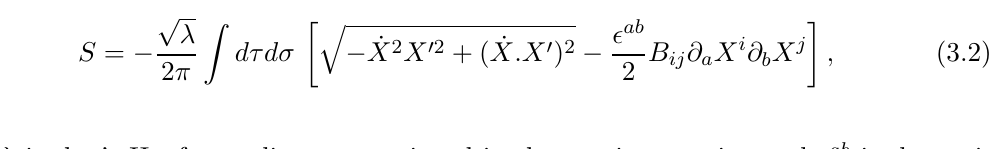
where the parameter b varies from 0 to 1 (0 (cid:20) b (cid:20) 1). Since we are dealing with fundamental string solution, the R-R (cid:12)eld is not relevant to us and can be ignored. The